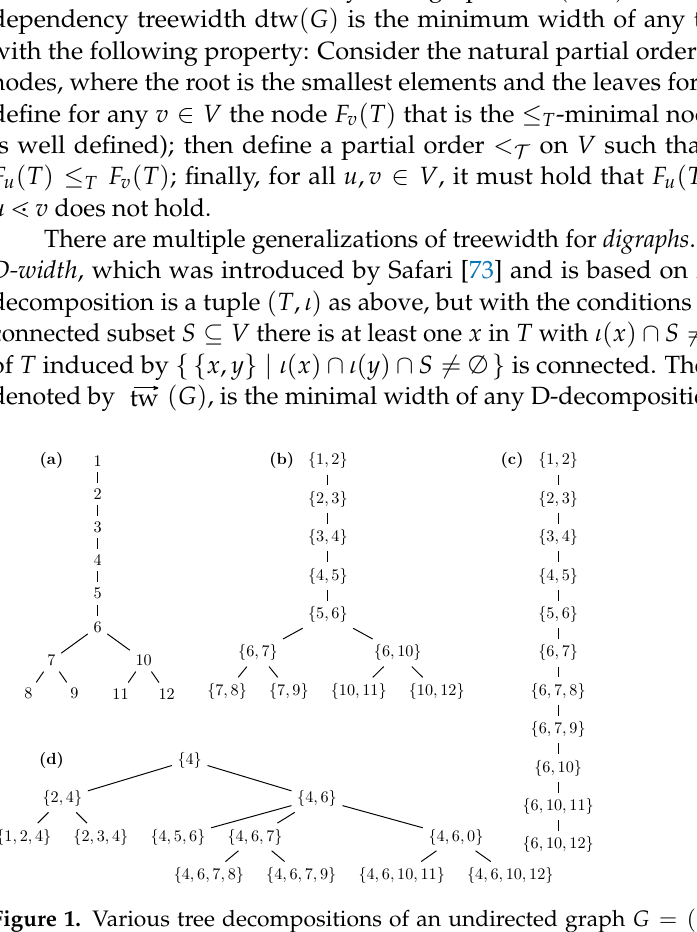
1, ( c ) pw ( G ) 2, and ( d ) td ( G ) 3. With respect to q -branched ≤ ≤ ≤ 1 and ( c ) tw 0 ( G ) ≤ ≤